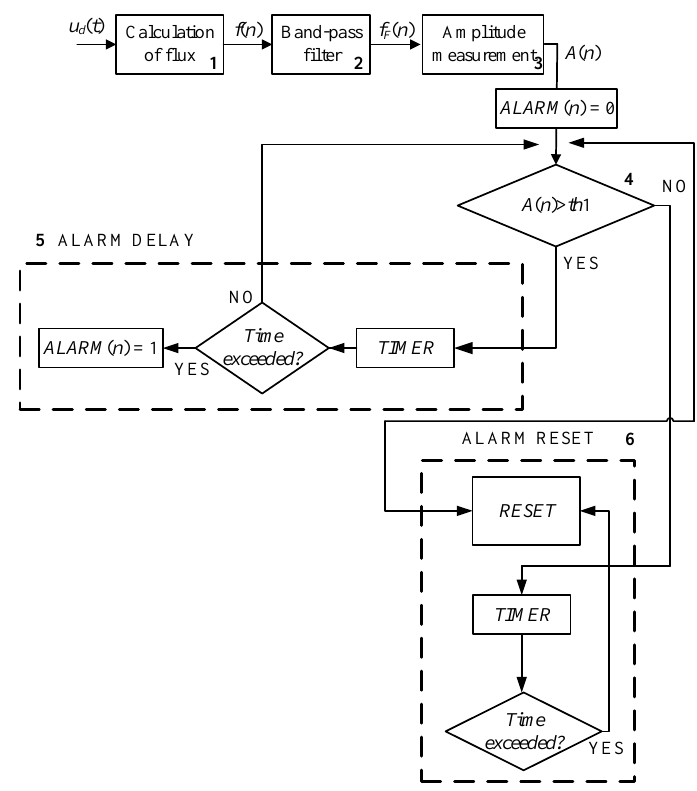
Figure 3. Current-voltage characteristic of parallel capacitance C 0 and nonlinear inductance L µ Figure 3. The structure of the proposed algorithm for the detection of ferroresonance connection.